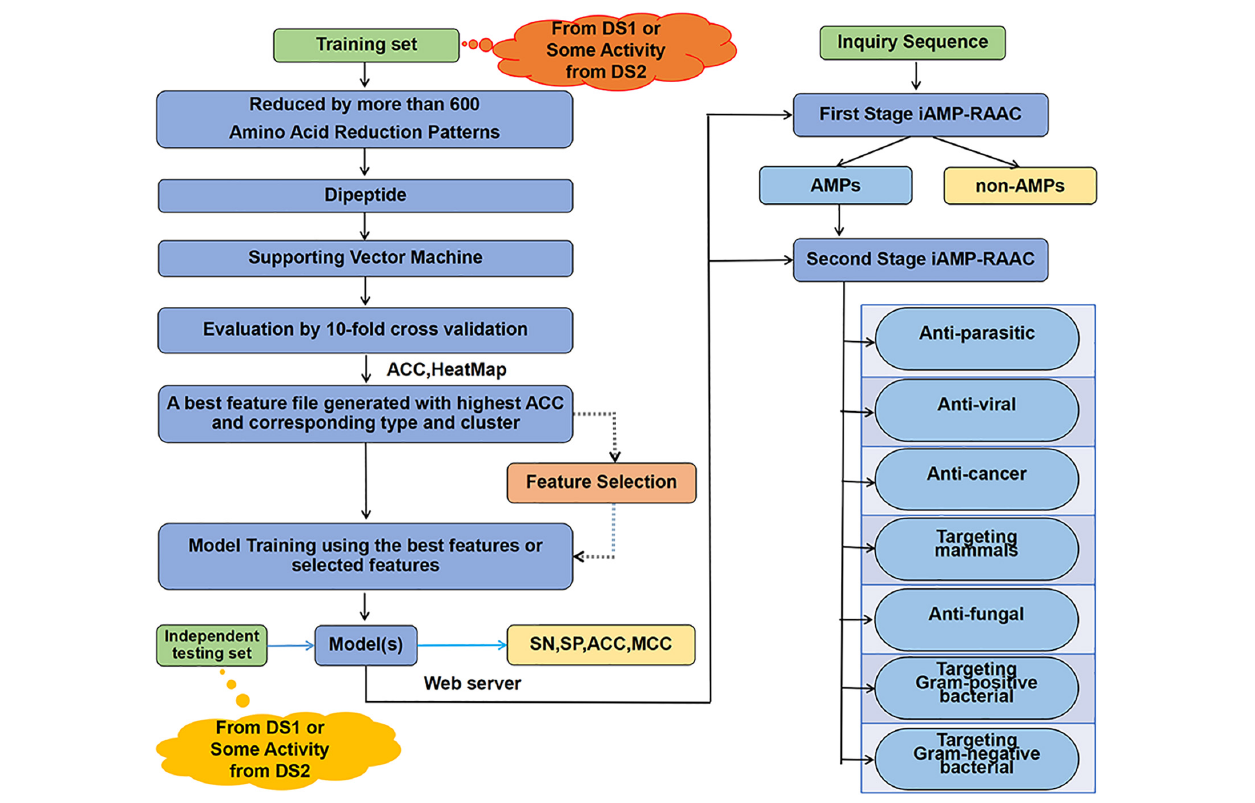
FIGURE 1 | The overall framework of our classifier. Training data set from DS1 or seven training data sets from DS2 are computed separately through amino acid reduction, dipeptide feature extraction, supporting vector machine model training and 10-fold cross-validation model evaluation. Then, the best feature file with the highest accuracy and the corresponding reduction type and cluster are determined. Next, the best features after feature selection or features from the best feature file are used for model training. Finally, on the one hand, the independent test set is used for testing performances of model; on the other hand, the web server is constructed with the trained model to provide two-stage prediction